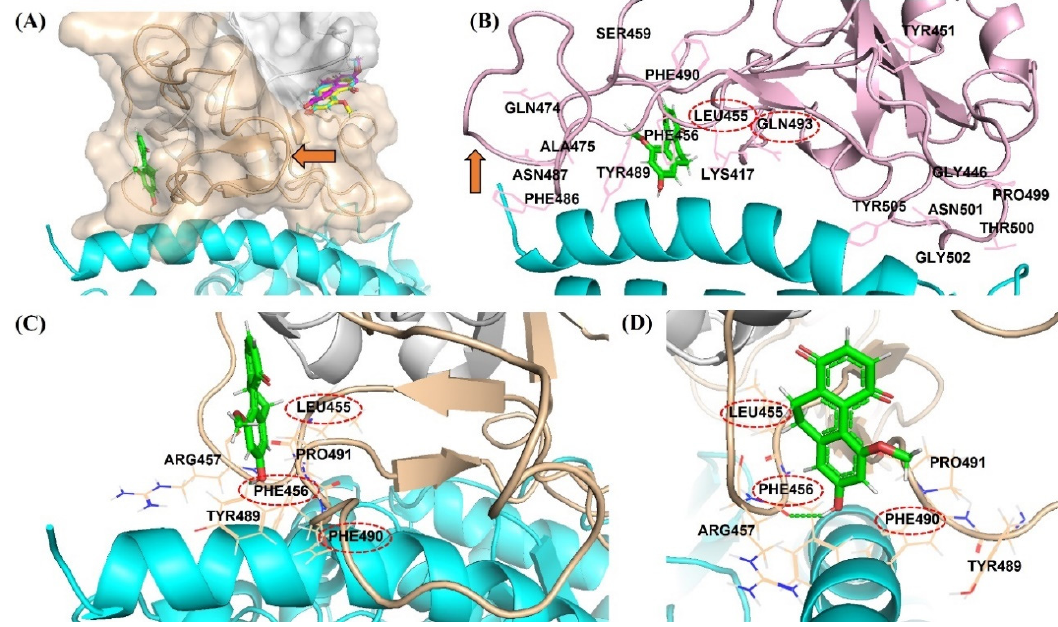
Figure 7. Binding mode of DB36 (green color stick) located in the binding motif (RBM) region (orange color surface) at the interface area of the spike protein interacting with ACE2 receptor (cyan helix color): ( A ) Binding location of DB36 at RBD of apo conformation of spike protein comparing with other hits; ( B ) The superimposition of the docked pose of DB36 with the ACE2 bound conformation of the spike protein (PDB code: 7KMB, pink color); The red arrow showed the flexible loop three (residues 472–490) of the spike protein in conformations of ( A ) apo (orange color) and ( B ) ACE2 bound (pink color); ( C , D ) The interactions of DB36 with the residues at the interface area of the spike protein interacting with the ACE2 receptor.